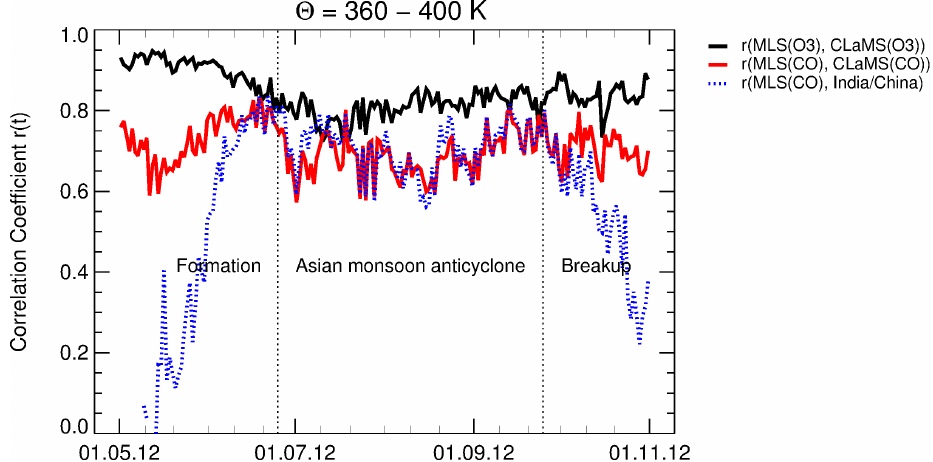
Figure 4. Correlation coefficients depending on time for tracer correlations patterns between MLS O 3 and CLaMS O 3 (black), between MLS CO and CLaMS CO (red), and between MLS CO and the CLaMS emission tracer for India/China (blue) for levels of potential temperature between 360 and 400K (see text for more details) in a region between 15 and 50 ◦ N and 0 and 140 ◦ E (shown as black rectangles in Fig. 2 and